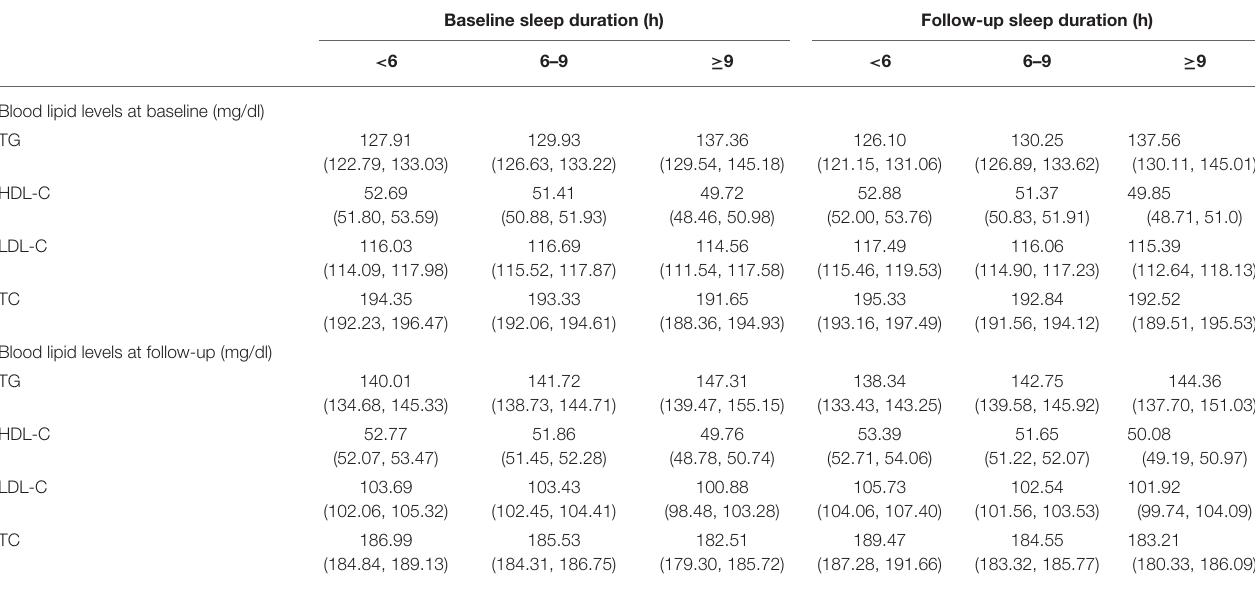
TABLE 2 | Mean values and 95% confidence intervals of TG, HDL-C, LDL-C and TC in different sleep duration groups. Baseline sleep duration